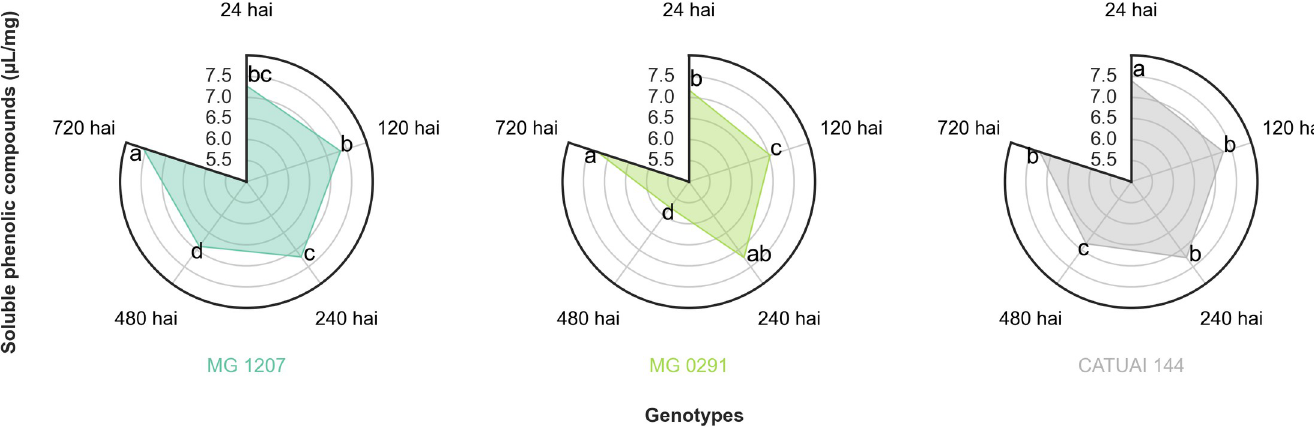
Fig 3. Contents of total soluble phenolic compounds ( μ L/mg) quantified in the leaves of the genotypes MG 1207, MG 0291, and Catuaı´Vermelho IAC 144 collected at 24, 120, 240, 480, and 720 h after inoculation of C . coffeicola . � Averages followed by the same lowercase letter in the same genotype do not differ by the Tukey’s test (p �